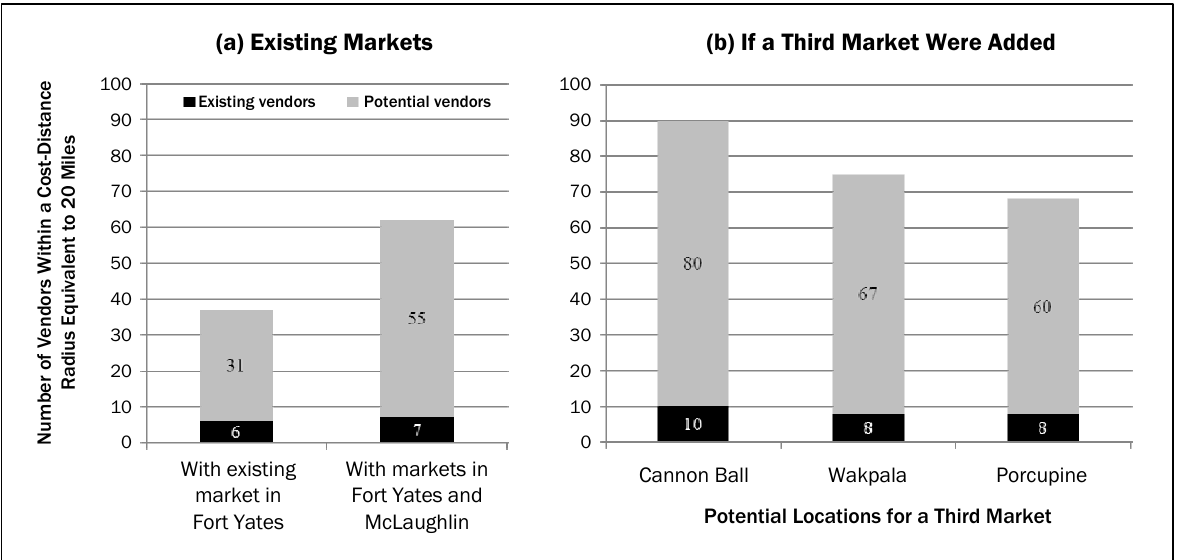
Figure 7. The Effect of Market Placement on Number of Vendors